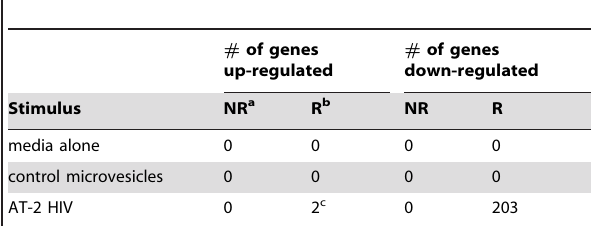
Table 3. Differential gene expression after in vitro stimulation with whole-inactivated